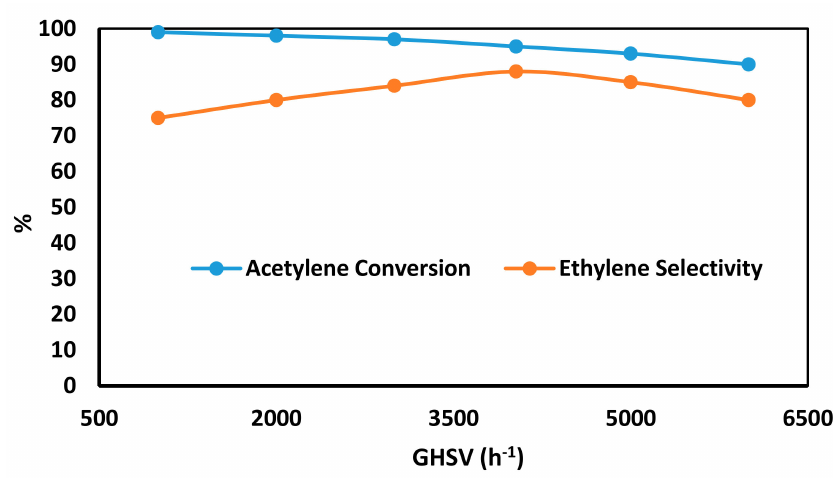
Figure 11. Effects of gas hour space velocity (GHSV) on acetylene conversion and ethylene selectivity at T = 55 ◦ C, R = 3, and p = 20 bar over 0.08%Pd0.29%Ir/H-Beta(i) catalyst.